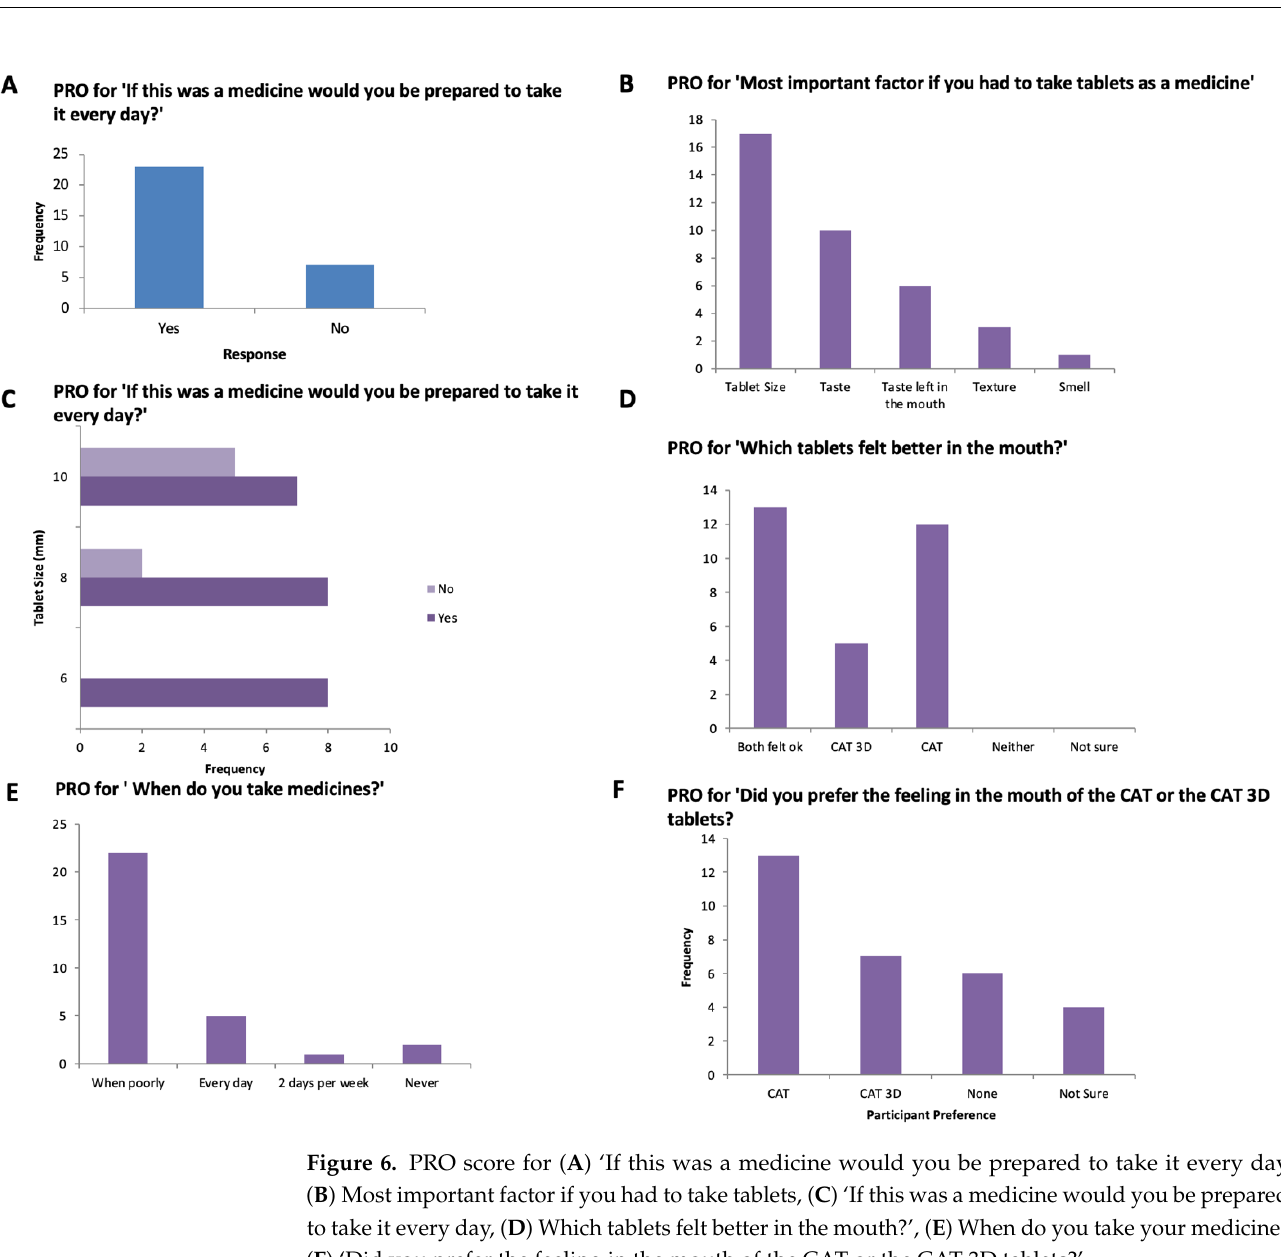
Figure 6. PRO score for ( A ) ‘If this was a medicine would you be prepared to take it every day, ( B ) Most important factor if you had to take tablets, ( C ) ‘If this was a medicine would you be prepared to take it every day, ( D ) Which tablets felt better in the mouth?’, ( E ) When do you take your medicine’, ( F ) ‘Did you prefer the feeling in the mouth of the CAT or the CAT 3D tablets?’.